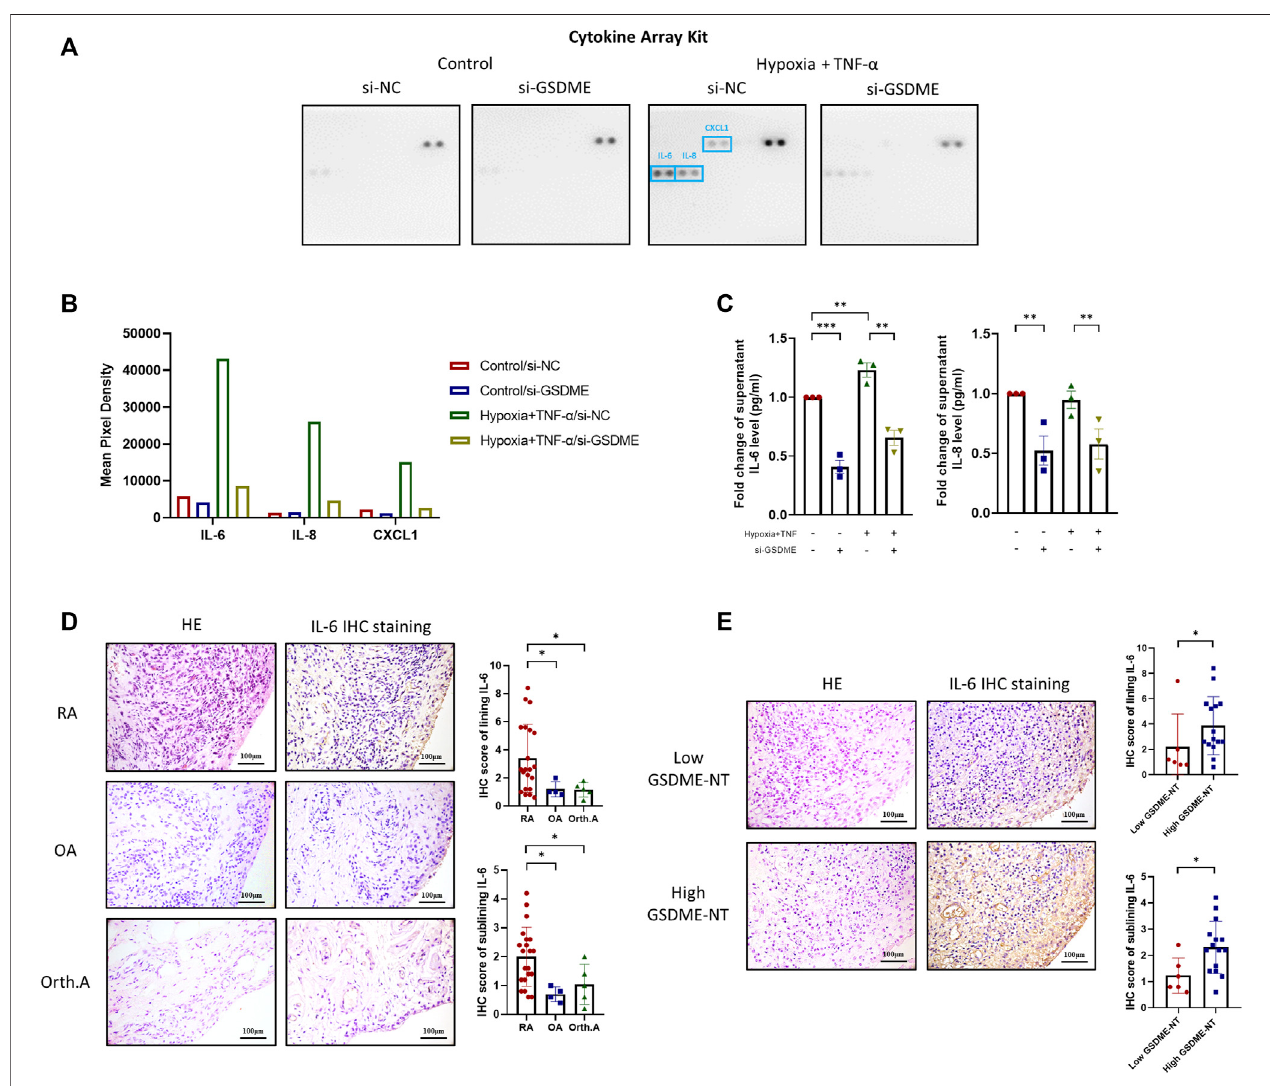
FIGURE 5 | Alleviation of IL-6 and other in fl ammatory cytokines release by downregulation of GSDME-mediated RA-FLSs pyroptosis. (A,C) After siRNA transfection and TNF- α + hypoxia treatment, cell culture supernatant was collected and the levels of cytokines and chemokines were measured using Proteome Pro fi ler Human Cytokine Array Kit from R&D systems (A,B) . Supernatant levels of IL-6, IL-8 were further veri fi ed by ELISA (n = 3) (C) . (D,E) HE and IHC staining for IL-6 of synoviumtissuesfromRA( n =21),OA( n =4)andOrth.A( n =5)patients(scalebar=100 μ m).RAsynoviumtissueswerefutherdivideintolowGSDME-NTlevel( n = 6) and high GSDME-NT level ( n = 15) groups based on matched GSDME-NT level determined by western blotting. Data are shown as mean ± s. e.m and results are representative of three independent experiments. * p < 0.05, ** p < 0.01, *** p < 0.001 using one-way ANOVA.